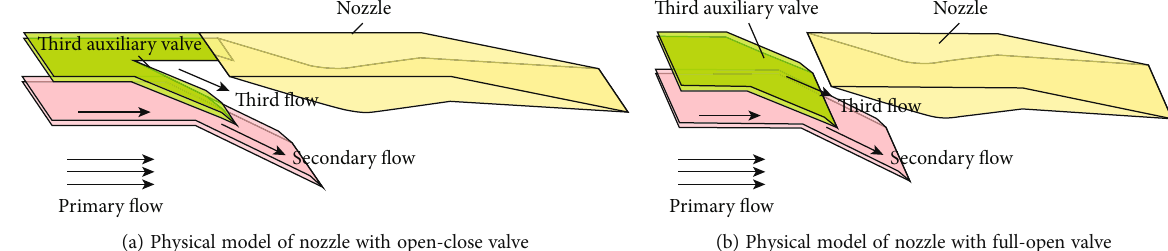
Figure 1: Three-dimensional physical model of the ejector nozzle.